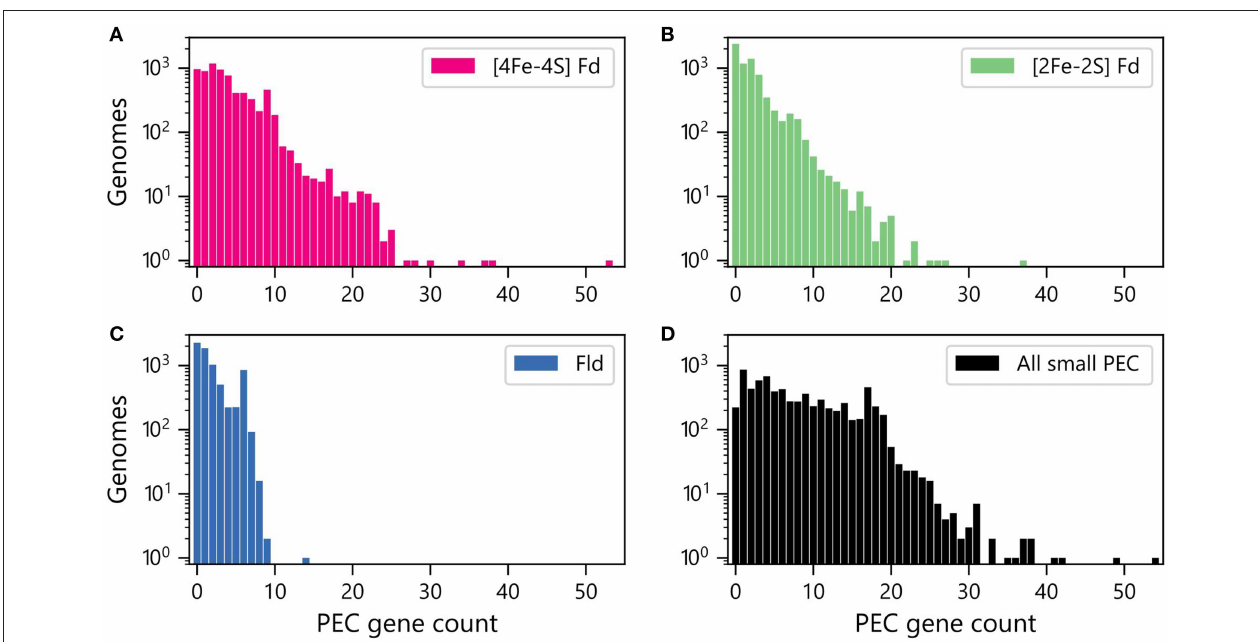
FIGURE 2 | Numbers of genomes having different abundances of PEC genes. Number of organisms with different (A) [4Fe-4S] Fd (red), (B) [2Fe-2S] Fd (green), and (C) Fld (blue) gene counts. (D) Number of organisms with different total numbers of PEC genes (black). The data shown was obtained by summing up the Fld, [2Fe-2S] Fd, and [4Fe-4S] Fd counts in each genome.